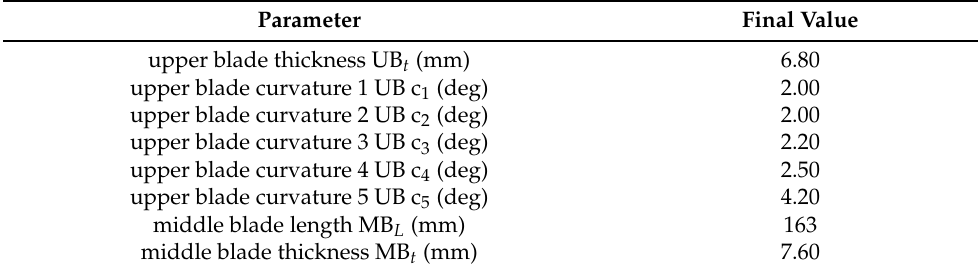
Table 7. Final geometric parameters that define the profile shape of MyFlex- γ elastic elements, for the 60 kg weight category. See Figure